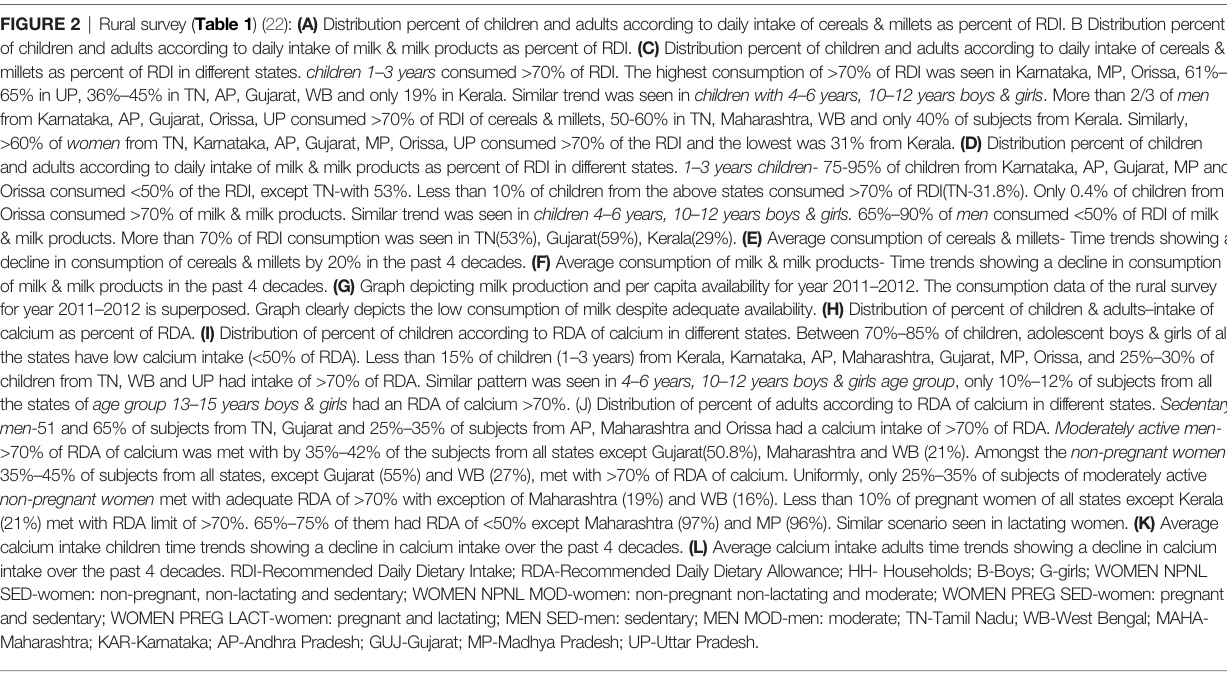
FIGURE 2 | Rural survey ( Table 1 ) (22): (A) Distribution percent of children and adults according to daily intake of cereals & millets as percent of RDI. B Distribution percent of children and adults according to daily intake of milk & milk products as percent of RDI. (C) Distribution percent of children and adults according to daily intake of cereals & millets as percent of RDI in different states. children 1 – 3 years consumed >70% of RDI. The highest consumption of >70% of RDI was seen in Karnataka, MP, Orissa, 61% – 65% in UP, 36% – 45% in TN, AP, Gujarat, WB and only 19% in Kerala. Similar trend was seen in children with 4 – 6 years, 10 – 12 years boys & girls . More than 2/3 of men from Karnataka, AP, Gujarat, Orissa, UP consumed >70% of RDI of cereals & millets, 50-60% in TN, Maharashtra, WB and only 40% of subjects from Kerala. Similarly, >60% of women from TN, Karnataka, AP, Gujarat, MP, Orissa, UP consumed >70% of the RDI and the lowest was 31% from Kerala. (D) Distribution percent of children and adults according to daily intake of milk & milk products as percent of RDI in different states. 1 – 3 years children - 75-95% of children from Karnataka, AP, Gujarat, MP and Orissa consumed <50% of the RDI, except TN-with 53%. Less than 10% of children from the above states consumed >70% of RDI(TN-31.8%). Only 0.4% of children from Orissa consumed >70% of milk & milk products. Similar trend was seen in children 4 – 6 years, 10 – 12 years boys & girls. 65% – 90% of men consumed <50% of RDI of milk & milk products. More than 70% of RDI consumption was seen in TN(53%), Gujarat(59%), Kerala(29%). (E) Average consumption of cereals & millets- Time trends showing a decline in consumption of cereals & millets by 20% in the past 4 decades. (F) Average consumption of milk & milk products- Time trends showing a decline in consumption of milk & milk products in the past 4 decades. (G) Graph depicting milk production and per capita availability for year 2011 – 2012. The consumption data of the rural survey for year 2011 – 2012 is superposed. Graph clearly depicts the low consumption of milk despite adequate availability. (H) Distribution of percent of children & adults – intake of calcium as percent of RDA. (I) Distribution of percent of children according to RDA of calcium in different states. Between 70% – 85% of children, adolescent boys & girls of all the states have low calcium intake (<50% of RDA). Less than 15% of children (1 – 3 years) from Kerala, Karnataka, AP, Maharashtra, Gujarat, MP, Orissa, and 25% – 30% of children from TN, WB and UP had intake of >70% of RDA. Similar pattern was seen in 4 – 6 years, 10 – 12 years boys & girls age group , only 10% – 12% of subjects from all the states of age group 13 – 15 years boys & girls had an RDA of calcium >70%. (J) Distribution of percent of adults according to RDA of calcium in different states. Sedentary men -51 and 65% of subjects from TN, Gujarat and 25% – 35% of subjects from AP, Maharashtra and Orissa had a calcium intake of >70% of RDA. Moderately active men - >70% of RDA of calcium was met with by 35% – 42% of the subjects from all states except Gujarat(50.8%), Maharashtra and WB (21%). Amongst the non-pregnant women 35% – 45% of subjects from all states, except Gujarat (55%) and WB (27%), met with >70% of RDA of calcium. Uniformly, only 25% – 35% of subjects of moderately active non-pregnant women met with adequate RDA of >70% with exception of Maharashtra (19%) and WB (16%). Less than 10% of pregnant women of all states except Kerala (21%) met with RDA limit of >70%. 65% – 75% of them had RDA of <50% except Maharashtra (97%) and MP (96%). Similar scenario seen in lactating women. (K) Average calcium intake children time trends showing a decline in calcium intake over the past 4 decades. (L) Average calcium intake adults time trends showing a decline in calcium intake over the past 4 decades. RDI-Recommended Daily Dietary Intake; RDA-Recommended Daily Dietary Allowance; HH- Households; B-Boys; G-girls; WOMEN NPNL SED-women: non-pregnant, non-lactating and sedentary; WOMEN NPNL MOD-women: non-pregnant non-lactating and moderate; WOMEN PREG SED-women: pregnant and sedentary; WOMEN PREG LACT-women: pregnant and lactating; MEN SED-men: sedentary; MEN MOD-men: moderate; TN-Tamil Nadu; WB-West Bengal;